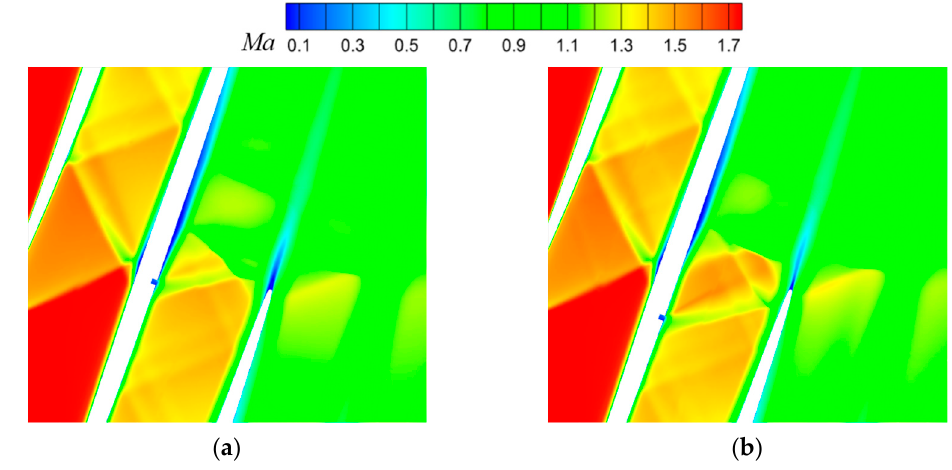
Figure 12. Density gradient magnitude contours with different locations of jet: ( a ) ∆ l = 2 δ ; ( b ) ∆ l = 5 δ ; ( c ) ∆ l = 8 δ ; ( d ) ∆ l = 10 δ .